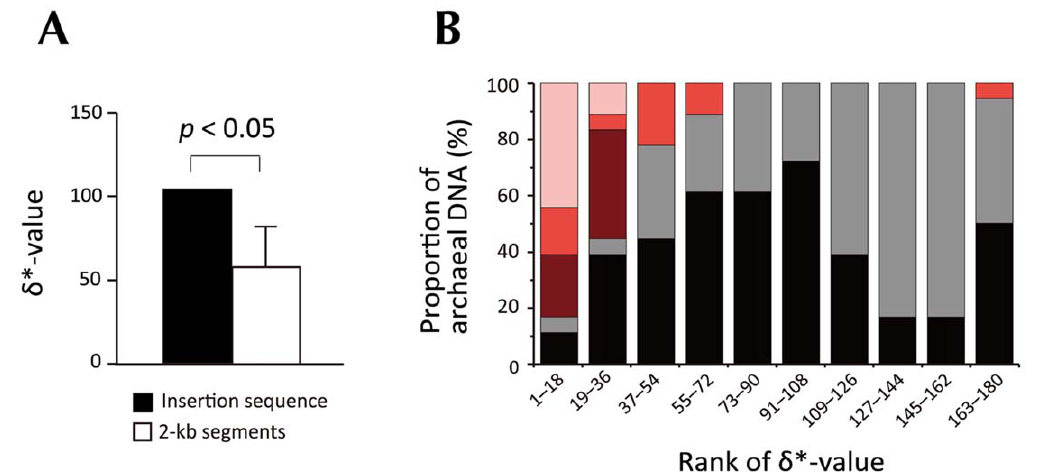
Figure 4. Dinucleotide bias analysis of the insertion sequence. (A) The average absolute dinucleotide relative abundance difference ( d *- value) for the composite genome and the insertion sequence (1,868 bp) was compared with the d *-values for the composite genome and each of the computationally generated 2-kb genomic segments ( n =1,681). An error bar represents the standard deviation. Statistical significance was determined by calculating the proportion of d *-values for the 2-kb segments that were greater than or equal to that of the insertion sequence. (B) Relative abundances of various types of archaeal DNA sequences, ranked according to the similarity of their dinucleotide content to the insertion sequence. In total, 180 DNA sequences were sorted in ascending order of their d *-values and divided into 10 bins. The sequences in each bin were categorized into five groups: plasmids encoding pNOB8-type integrases (pink, n =10); plasmids in the order Sulfolobales (red, n =11); chromosomes in the order Sulfolobales (dark red, n =11); other plasmids (dark grey, n =74), and other chromosomes (black, n =74). See Table S2 for the complete list of all 180 DNAs.